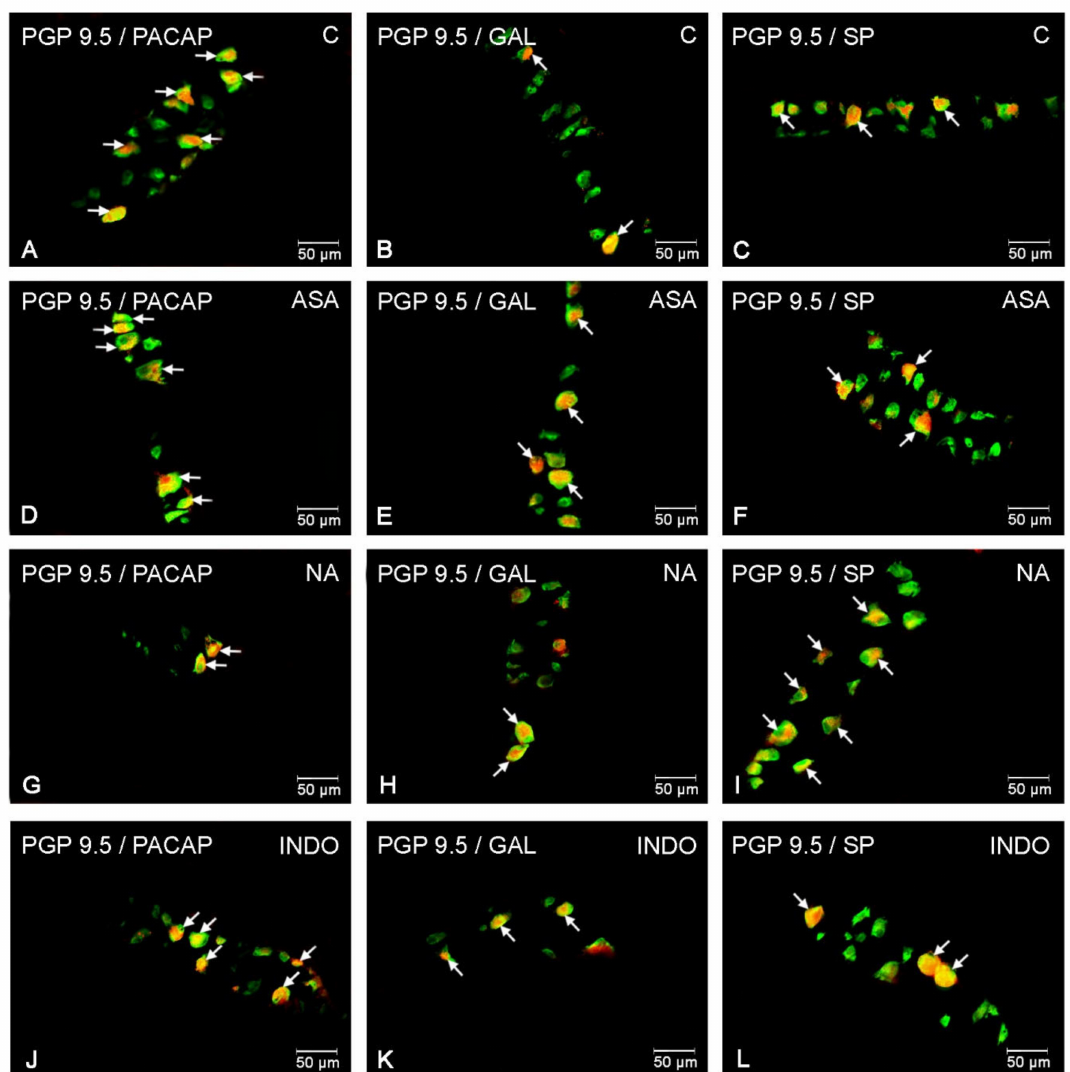
Figure 3. Myenteric neurons of porcine jejunum containing the protein gene-product 9.5 (PGP 9.5) (used as pan neuronal marker) and PACAP, GAL and SP in physiological conditions ( A – C ) and following aspirin ( D – F ), naproxen ( G – I ), in- domethacin ( J – L ) treatment. The photographs were created by digital superimposition of two color channels (green for PGP 9.5 and red for selected neurotransmitter). The arrows in the photos point to co-localization of both antigens in the studied